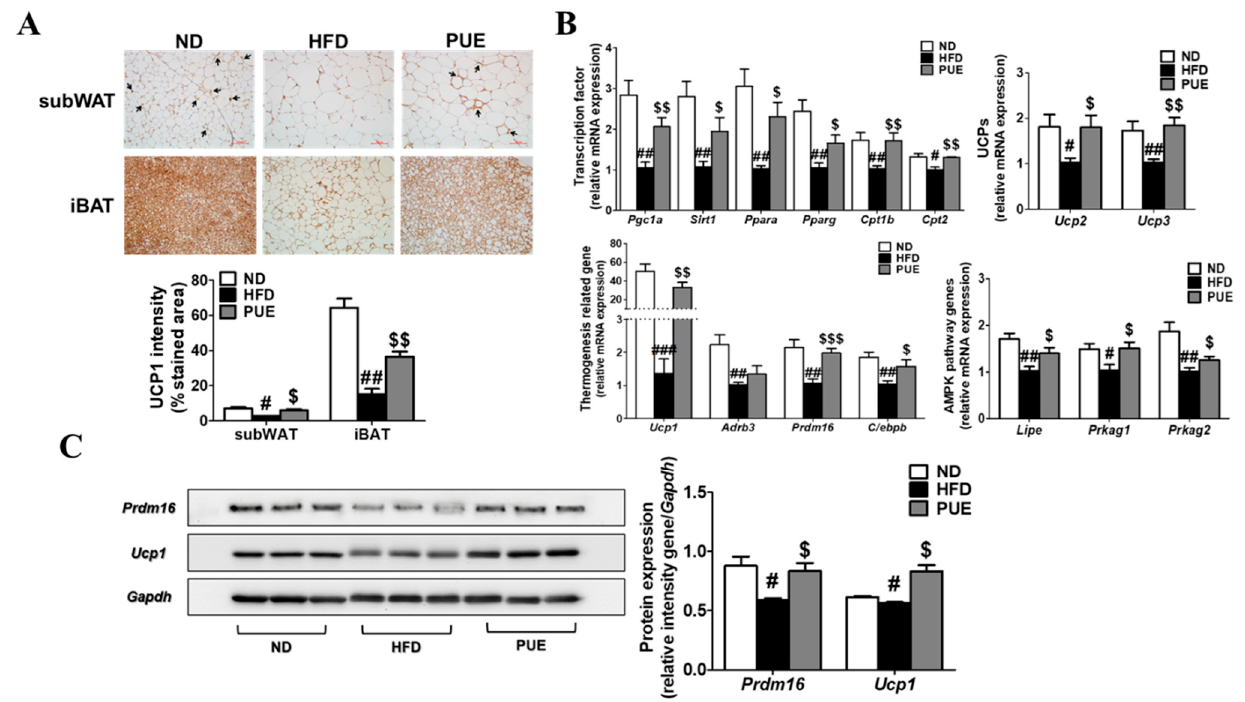
Figure 6. Effect of P. umbrosa root extract on activating iBAT and promoting subWAT. ( A ) Immunostaining of UCP1 by IHC (×200) and UCP1 intensity (%); ( B ) Browning-related gene expression in subWAT; ( C ) Western blot analysis of PRDM16 and UCP1 expression in iBAT. ( A ) Arrow indicates UCP1-positive staining. ( A – C ) Data are presented as means ± SEM.; ND, normal diet (AIN-93G); HFD, high-fat diet (60 kcal% fat); PUE, HFD + P. umbrosa root extract (1% w / w ). Significant differences between HFD and ND are indicated by # p < 0.05; ## p < 0.01; ### p < 0.001. Significant differences between HFD and PUE are indicated by $ p < 0.05; $$ p < 0.01; $$$ p < 0.001. IHC, immunohistochemistry.